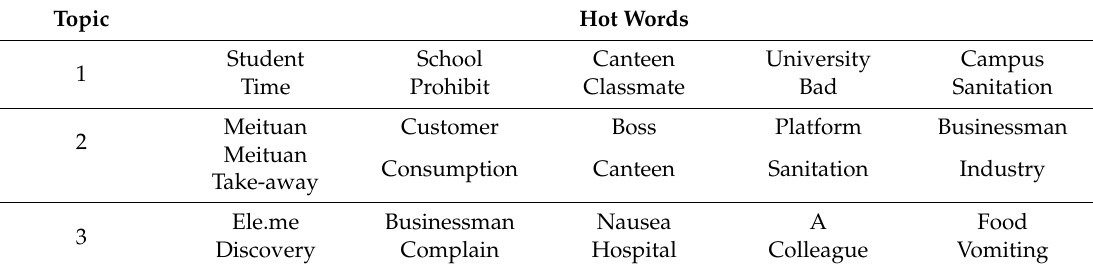
Table 6. Distribution of topics of negative